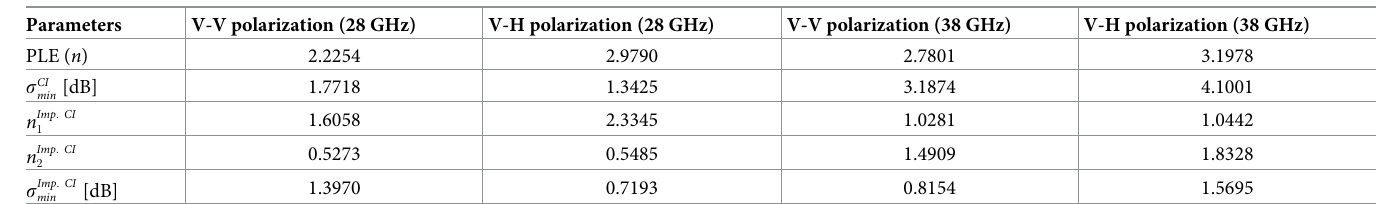
Table 2. Parameters for the standard CI and improved CI models.